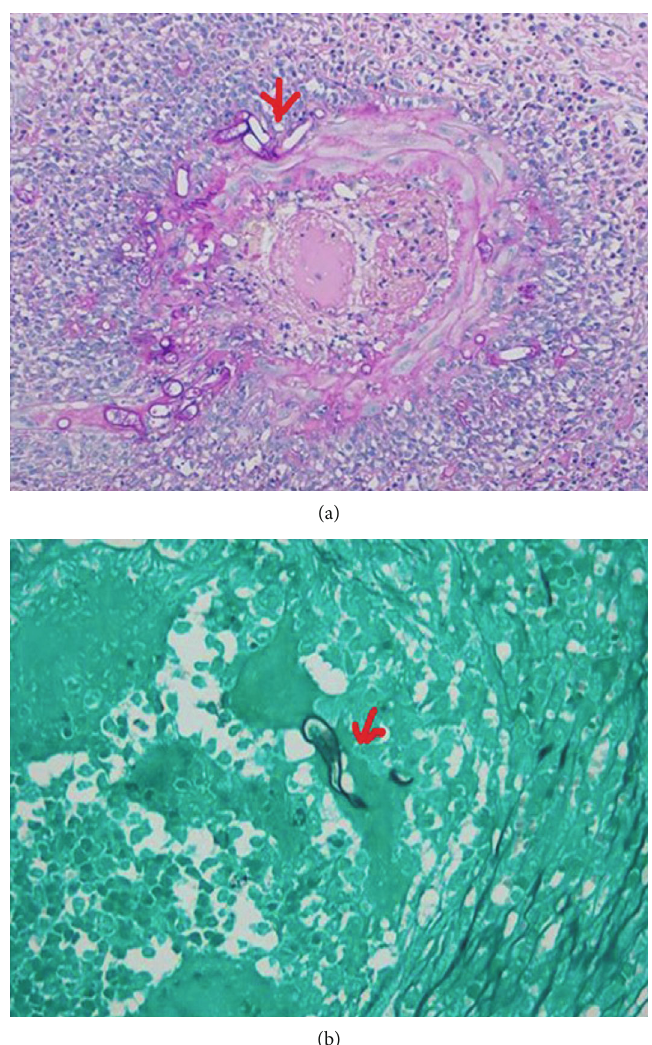
Figure 12: A small intestine biopsy specimen shows the Splendore-Hoeppli phenomenon in a patient diagnosed with colonic Basidiobolomycosis ((a) red arrow). Grocott stain of the small intestine shows Basidiobolus hyphae (red arrow), which appears thin- walled, septated hyphae surrounded by eosinophilic material (b). (Images obtained with permission from Kurteva et al.